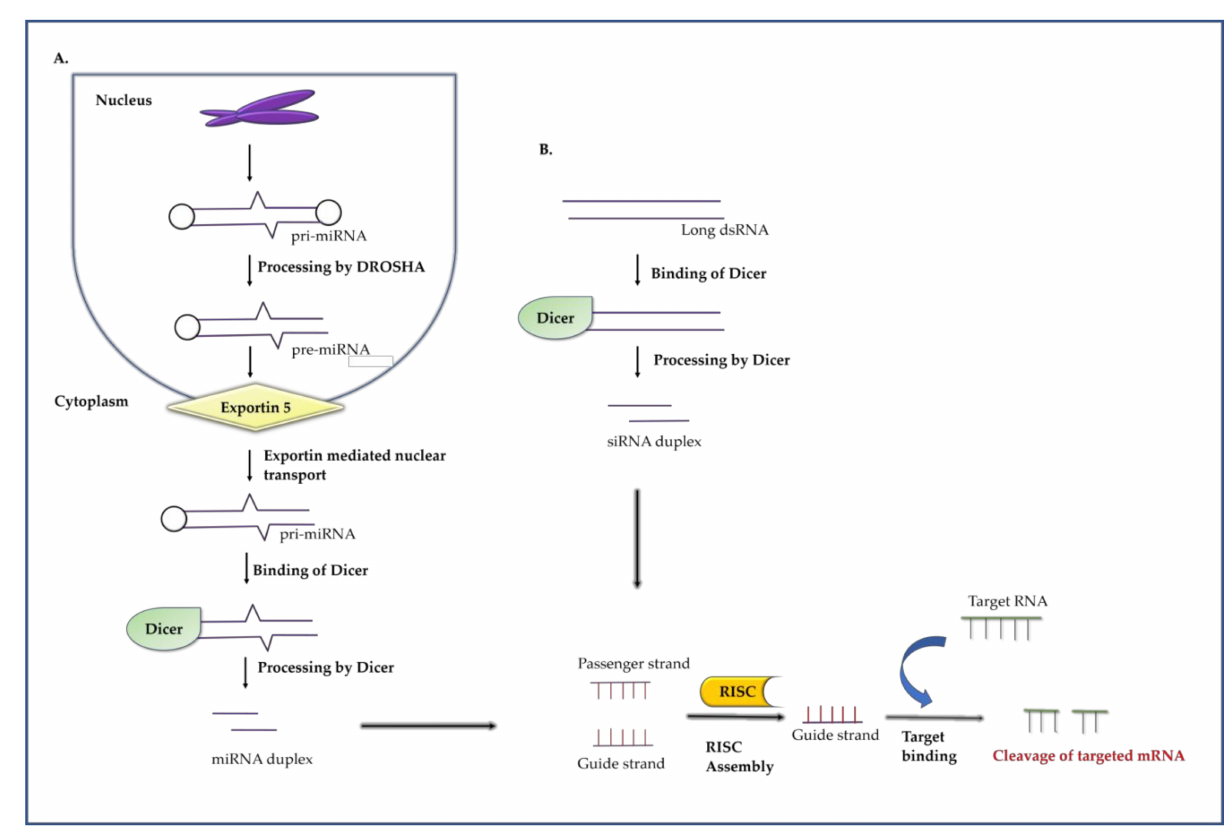
Figure 4. Gene silencing mechanism of RNA interference. ( A ). The pri-miRNA is processed into pre-miRNA with the help of enzyme DROSHA during the first step of miRNA mediated gene silencing. The pre-miRNA is transported into the cytoplasm from nucleus with the help of an enzyme named exportin-5. The enzyme Dicer processed the pre-miRNA into miRNA duplex. The miRNA duplex then associates with RISC complex and cleaves the targeted mRNA. ( B ). Long dsRNA generates small siRNA duplex by the action of DICER. The RISC loaded onto the duplex and the complex binds with the target complementary strand. The mRNA strand is now cleaved through endogenous mechanism of AGO2 endonuclease present in RISC